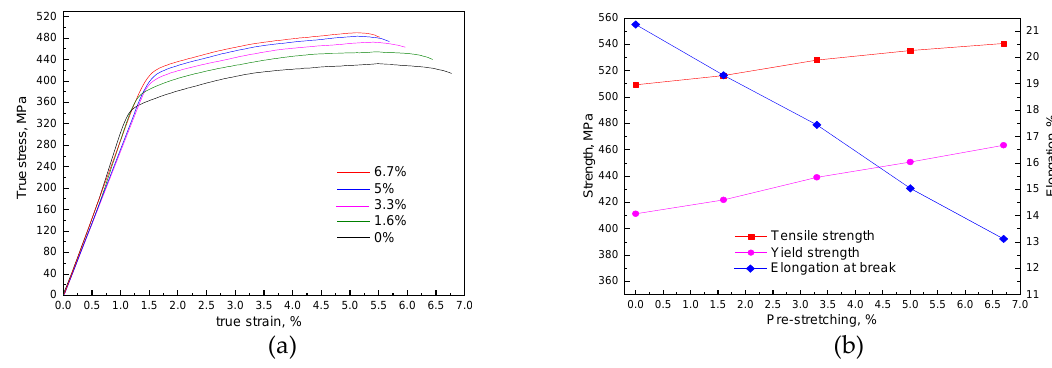
Figure 4. Profiles of ( a ) the true stress-strain for 7055 in T6 state alloys with different levels of pre-stretching at room temperature, and ( b ) variations of mechanical properties for the 7055 in T6 state alloys with different levels pre-stretching before creep-aging.